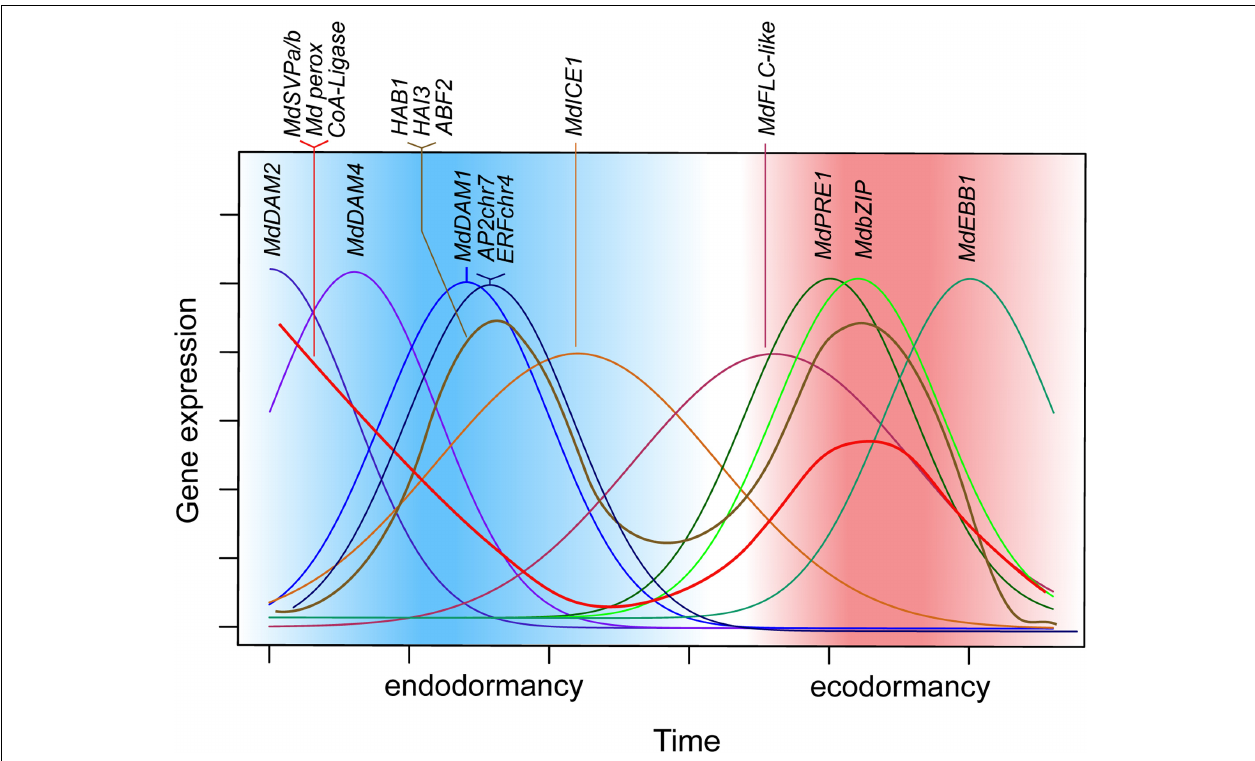
FIGURE 5 | Schematic representation of candidate-gene expression patterns during dormancy progression. Expression of MdDAM2, MdDAM4, and MdDAM1, as well as AP2chr7 and ERFchr4 , occurs in successive order with a single peak during endodormancy. Similarly, during ecodormancy, expression of MdPRE1, MdbZIP, and MdEBB1 show single, consecutive peaks of expression. Expression of MdSVPa, MdSVPb, MdPeroxidase, and CoA-Ligase is high at the beginning of dormancy and during mid ecodormancy and drops toward phase transitions of endodormancy to ecodormancy and of ecodormancy to bud break. Thus, it appears that multimeric complexes of MdSVPa/b with MdDAM1 , MdDAM2 , MdDAM4, and MdFLC-like can be formed all through dormancy but phase transitions. MdICE1 and MdFLC-like show broader expression curves that also occur in successive order; however, they are both highly expressed during endodormancy to ecodormancy